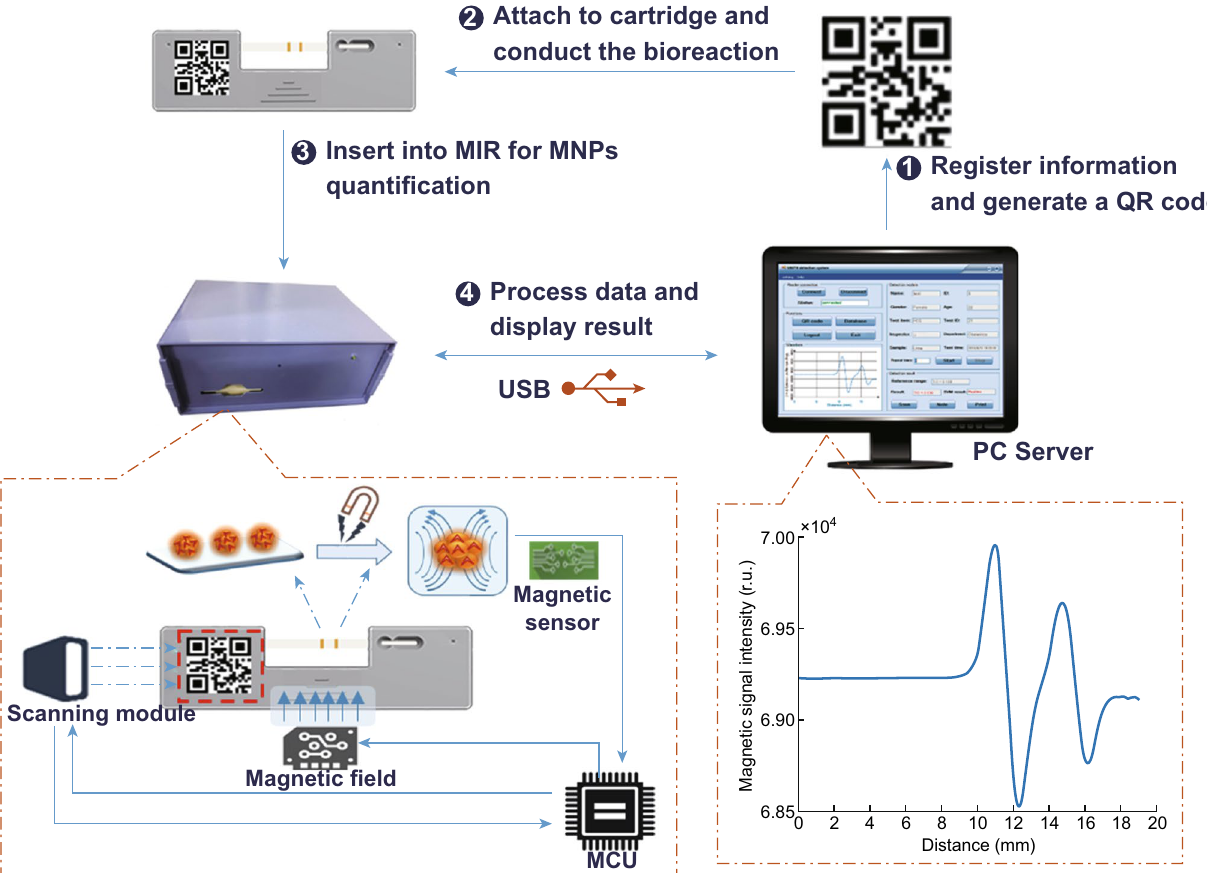
Fig. 2 Assay procedure comprising brief working principle of